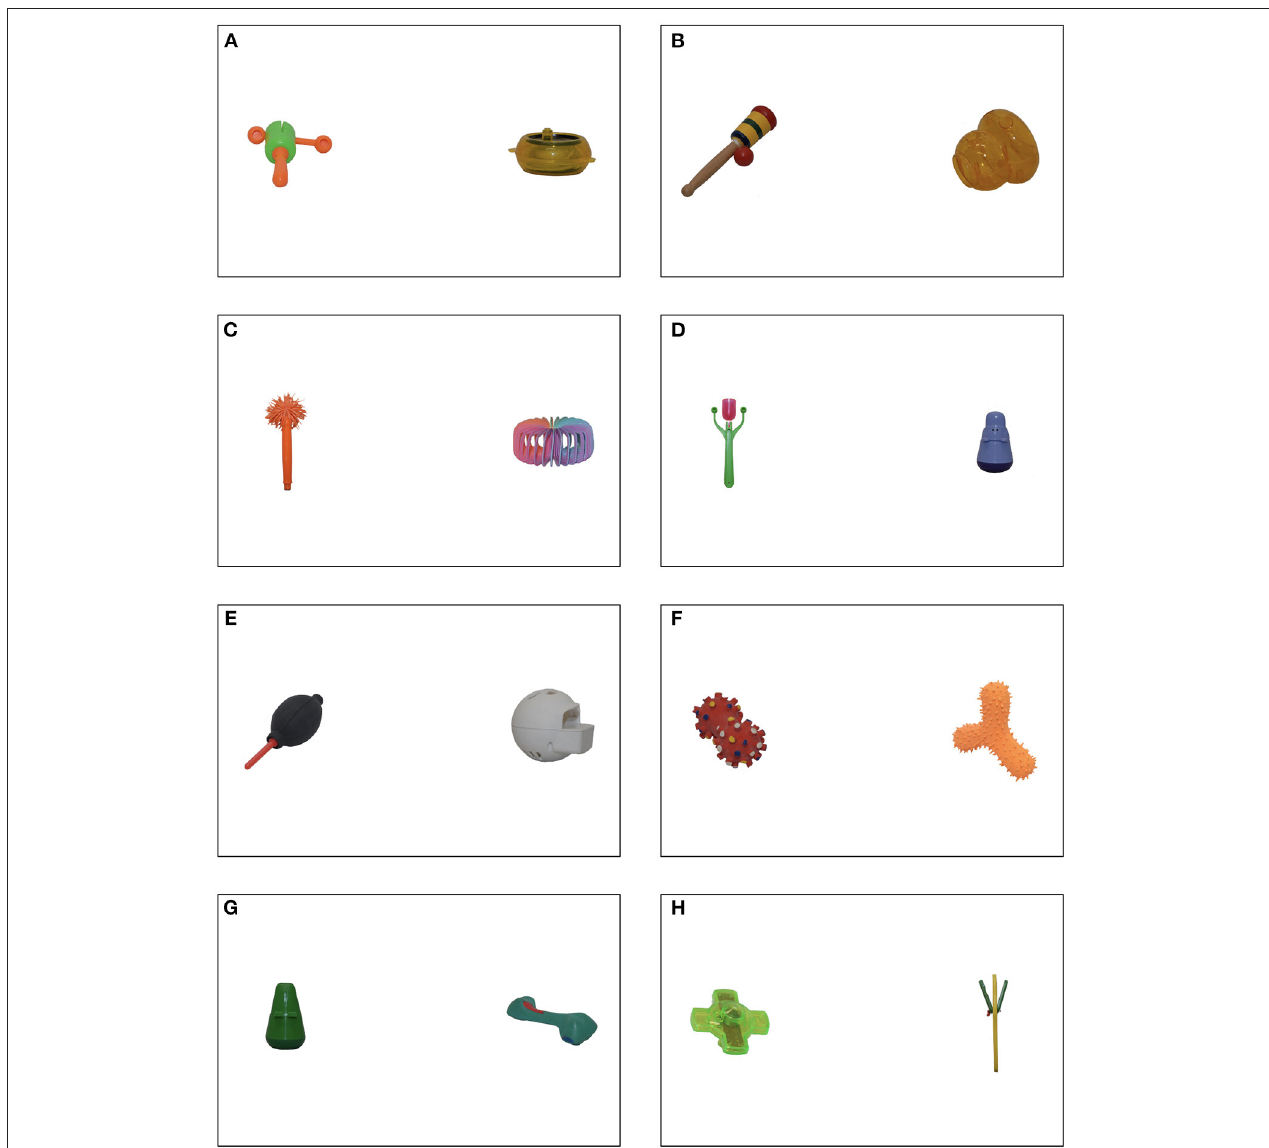
FIGURE 1 | The pairs of objects used in the study. Pairs (A) through (E) show the handled object on the left. Pairs (F) through (H) show the handled object on the right. Objects came from Horst and Hout (2016).